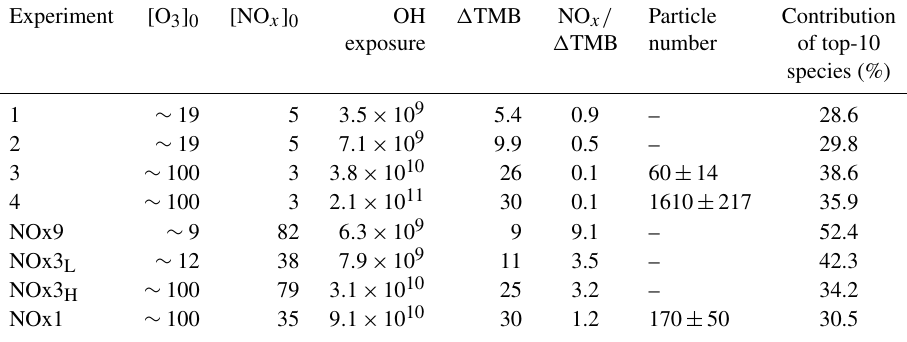
Table 1. Experimental conditions for experiments with 30ppb TMB. Ozone and initial NO x concentration at time zero are given in parts per billion (ppb) and explicitly modelled OH exposure in number of molecules second per cubic centimetre (molecscm − 3 ). TMB reacted ( (cid:49) TMB) in parts per billion (ppb) after a reaction time of 34s and particle number concentration given in no.cm − 3 after reaching steady state in the Go:PAM. RH in all experiments was 38%.